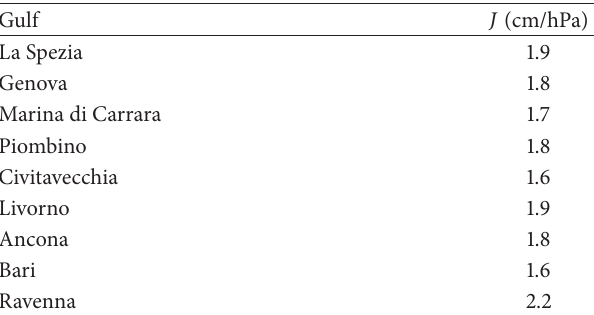
Table 2: Inverse hydro-barometric factor ( 𝐽 ) estimation in different Italian ports—one year